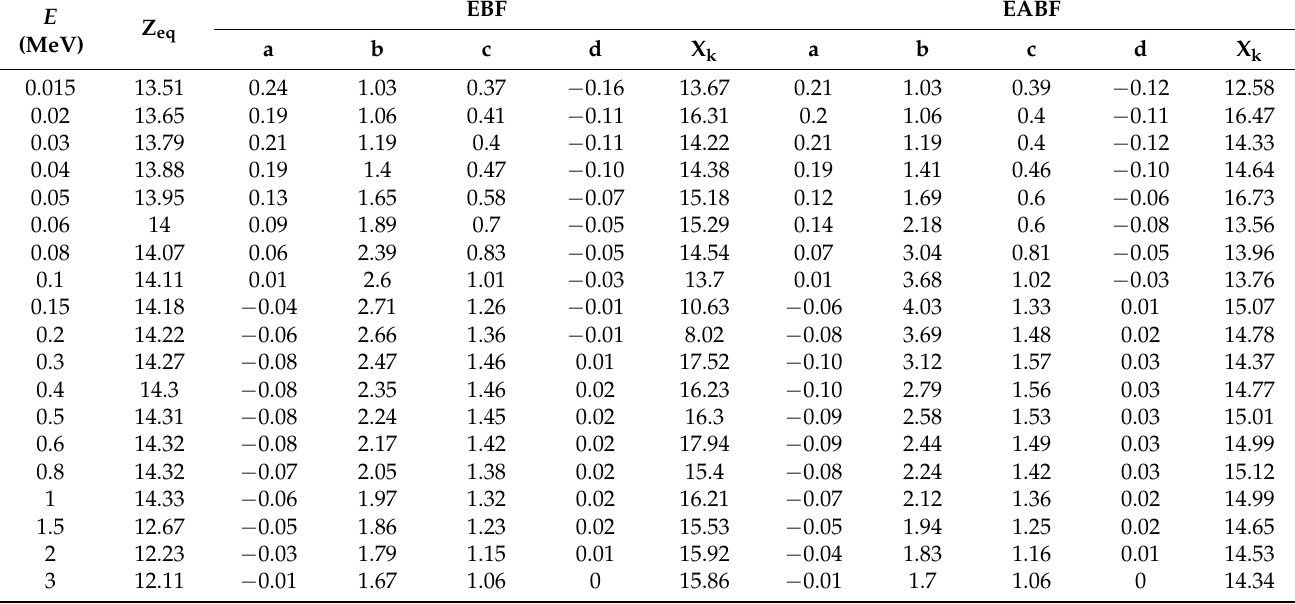
Figure 12. Change in equivalent atomic number (Z eq ) against incoming photon energy. EBF and EABF are two factors used to determine the total flux of gamma radiation. The variation of both parameters with the incoming energy for S1 and S6 is presented in Figure 13. Moreover, Table 4 illustrates the G-P fitting factors of the EBF and EABF values for S6, which is optimized at gamma energies ranging from 0.015 to 15 MeV. Table 4. G-P fitting parameters for S6 at various gamma photon energies.